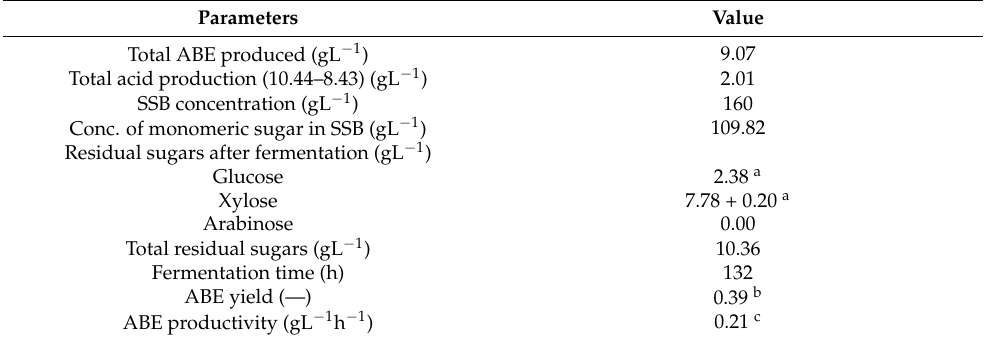
Table 4. A summary of butanol/ABE production from 160 gL − 1 SSB in an integrated